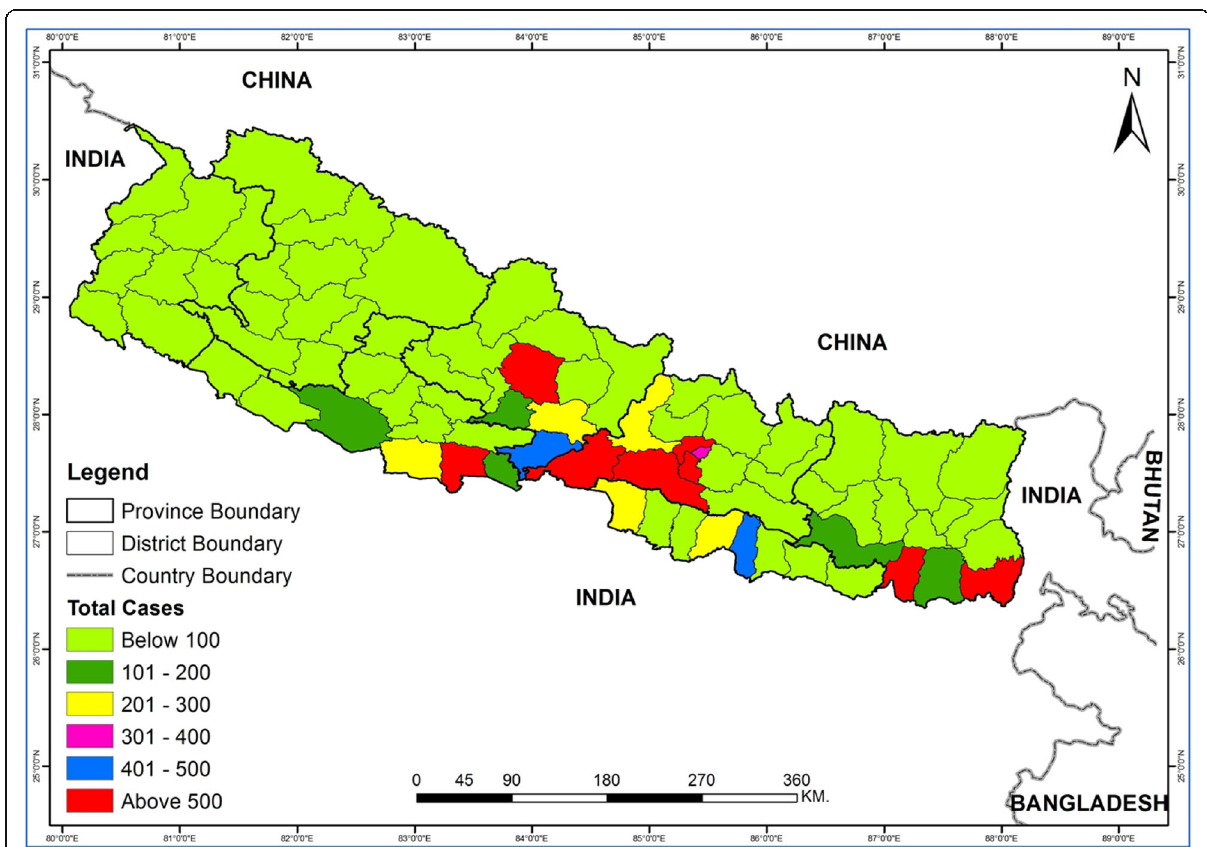
Fig. 1 Map of the landlocked Nepal bordered by India and China and showing the total number of confirmed dengue cases reported from different districts of Nepal from fiscal year 2014/2015 until 2019/2020. Data were retrieved from the Epidemiology and Disease Control Division, Department of Health Services, Ministry of Health and Population, Government of